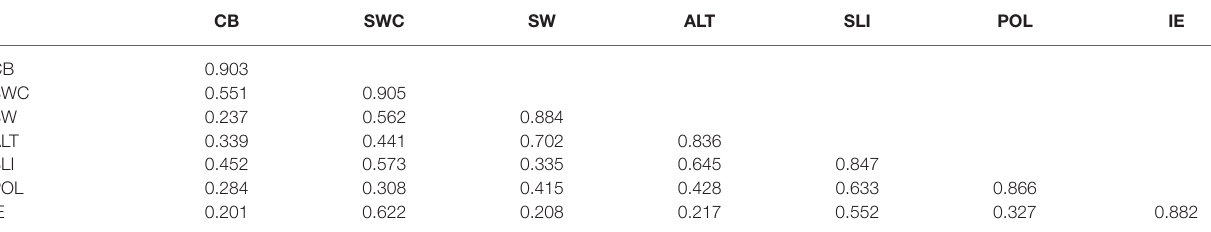
TABLE 2 | Square root of AVE value and variable correlation